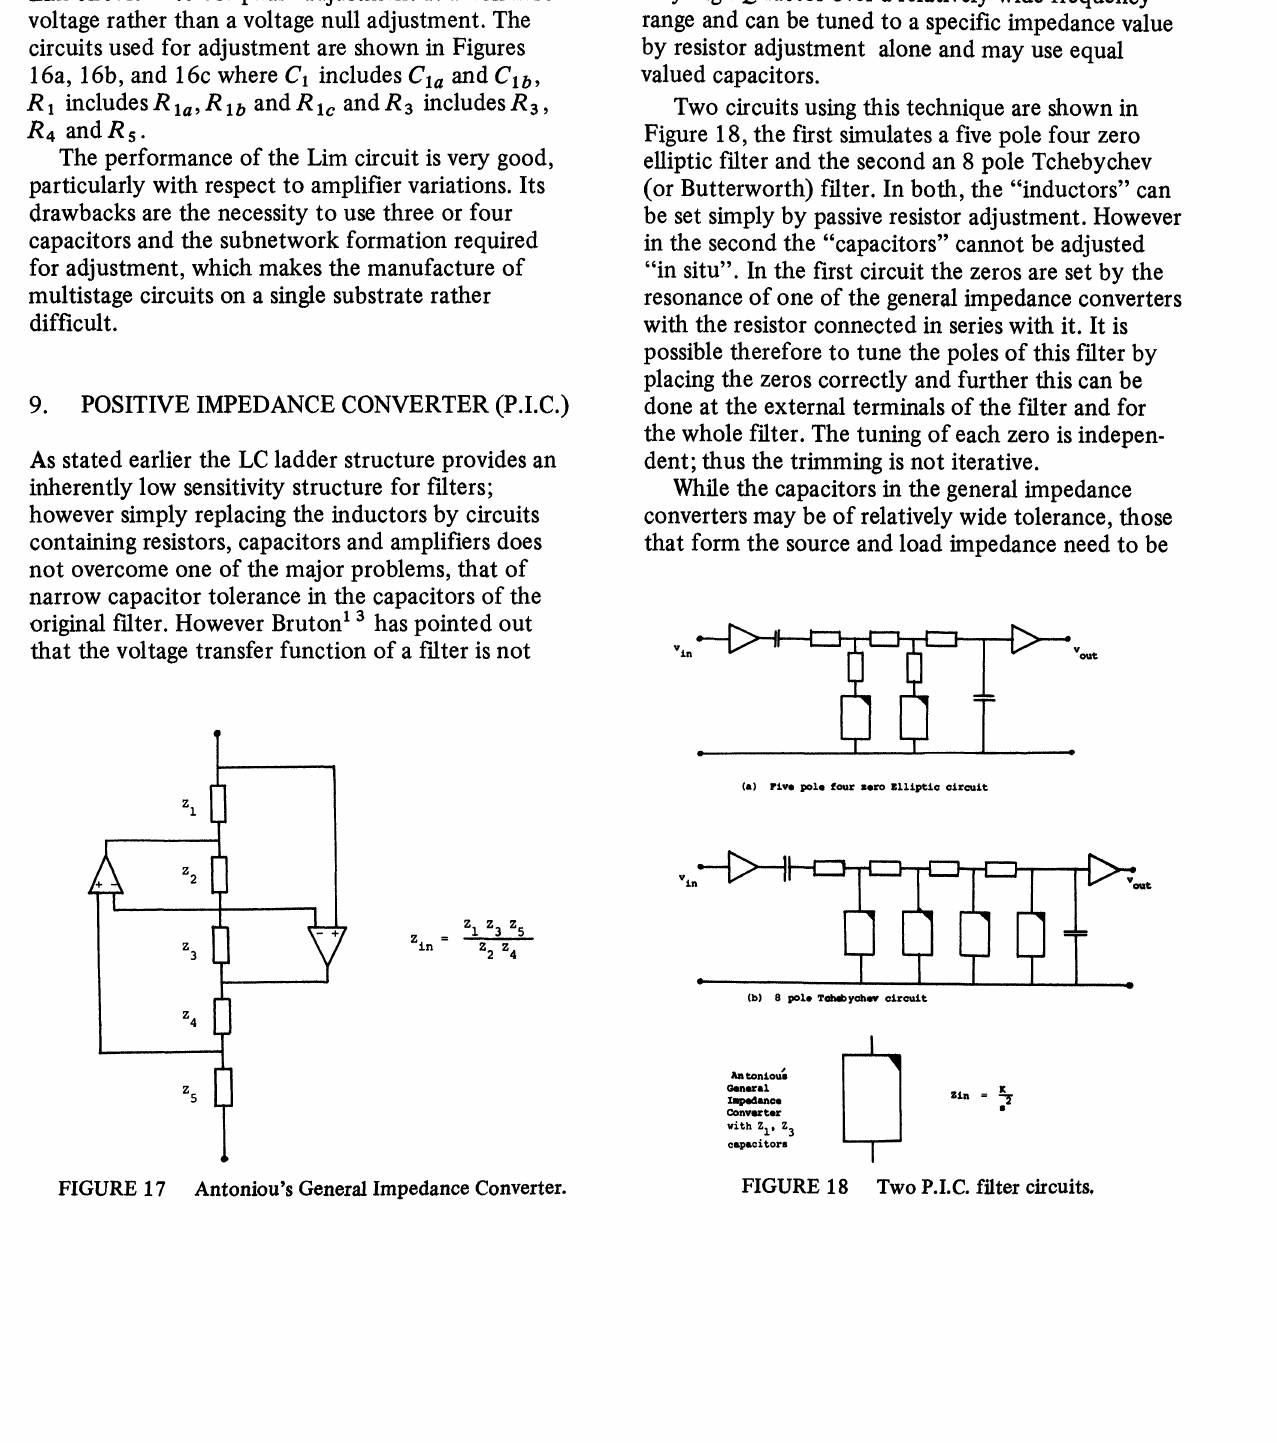
Antoniou’s General Impedance